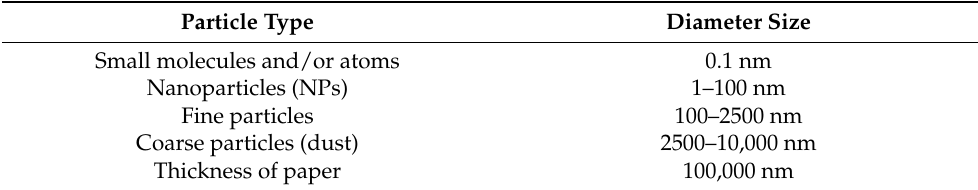
Table 1. Particle types and its diameter